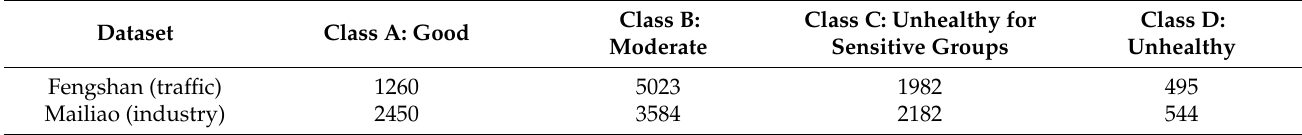
Table 2. The number of records of each class in two datasets.